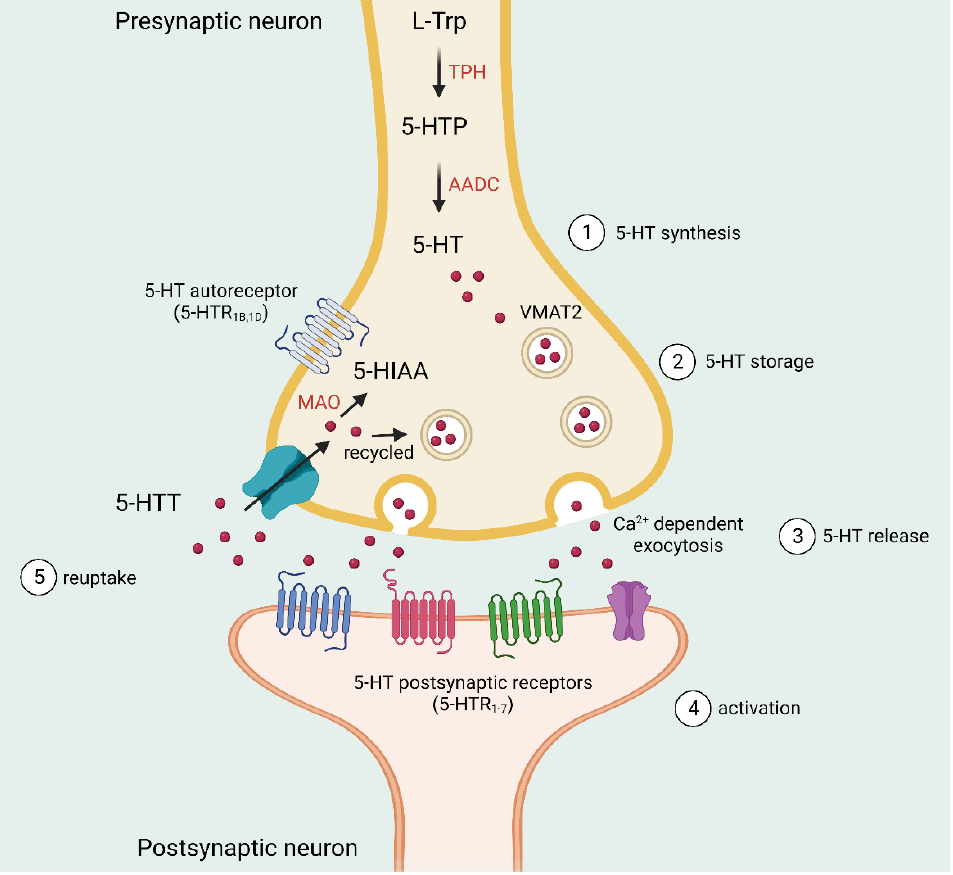
Figure 2. Serotonin pathway. ( 1) L-tryptophan is converted to 5-HT by TPH and AADC enzymes. (2) 5-HT is then taken up into vesicles in the axon terminal via VMAT2. (3) After an action potential, 5-HT is released into the synapse. 5-HT can also interact with presynaptic and postsynaptic recep- tors. (4) All 5-HT receptors are post-synaptically expressed on non-serotonergic neurons, and auto- receptors are located pre-synaptically on the serotonergic neurons. (5) Free 5-HT is removed from the synapse by 5-HTT, which controls the extent and duration of 5-HT receptor activation. Further- more, 5-HT can be metabolized by MAO and aldehyde dehydrogenase into 5-HIAA, which is ex-